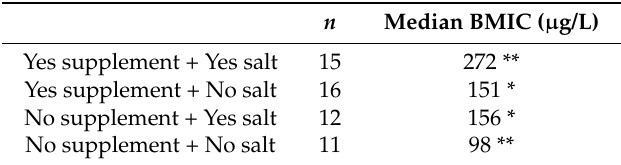
Table 2. Effect of iodine supplement and iodised salt use on BMIC.